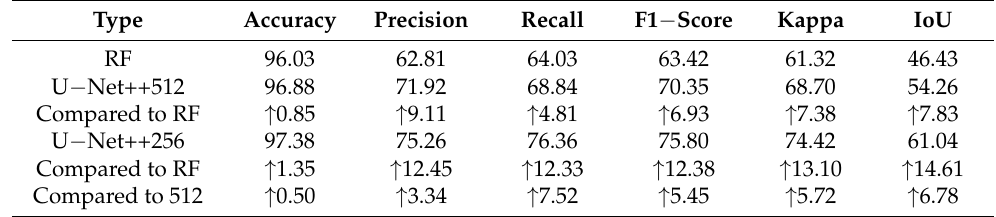
Table 2. Performance of RF, U − Net++256 and U −